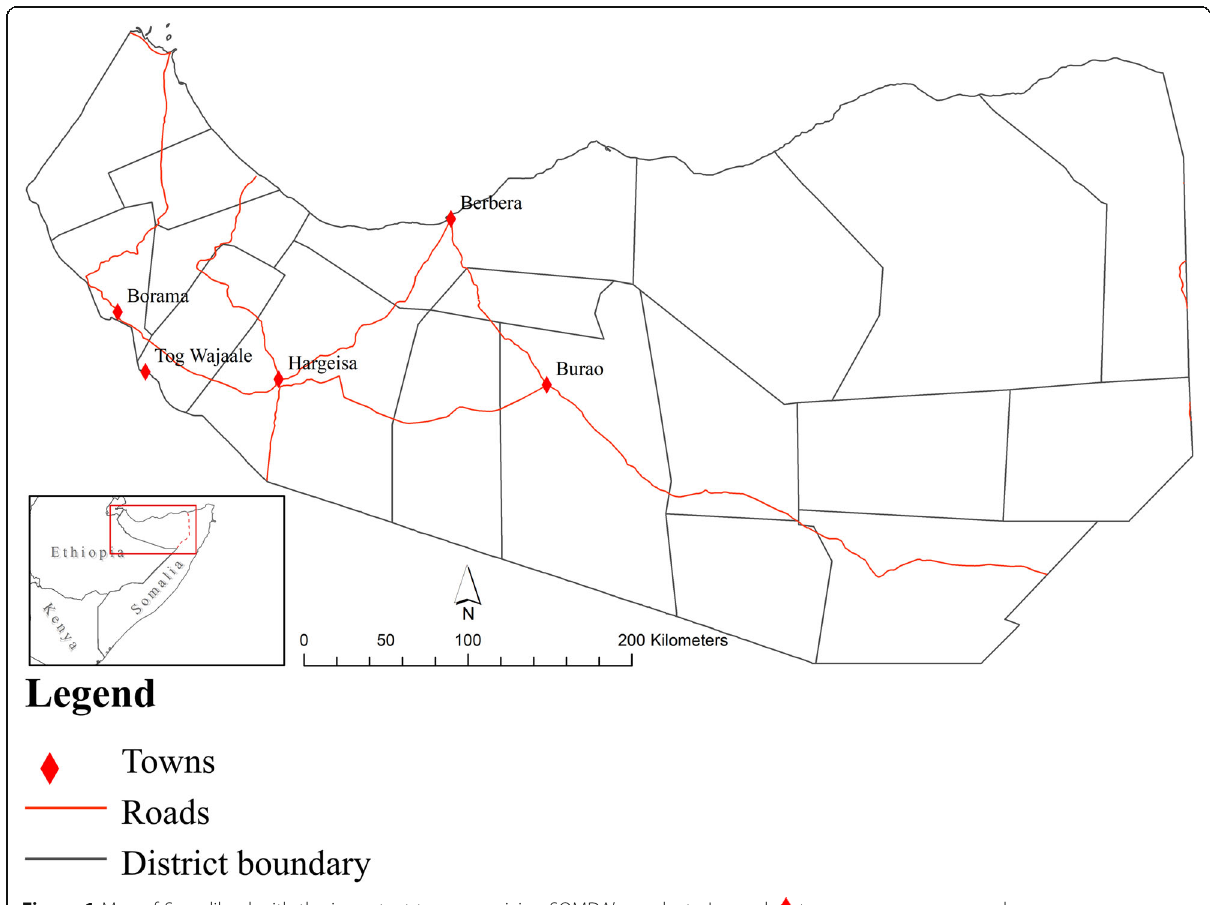
Figure 1 Map of Somaliland with the important towns receiving SOMDA ’ s products. Legend: towns, roads, district